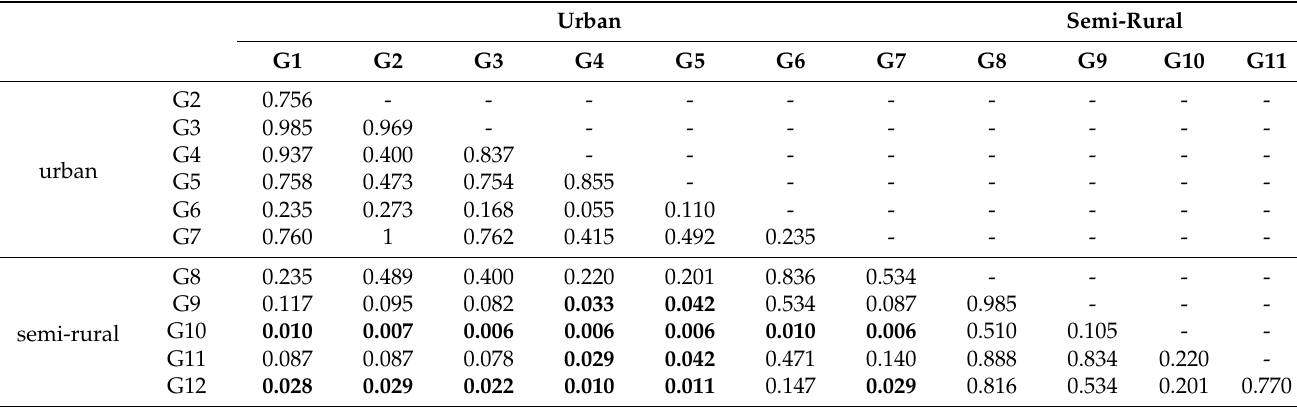
Table 4. Pairwise comparisons of pollen deposition 2020 between all sites using Wilcoxon rank sum test, bold values indicate significant differences ( p <